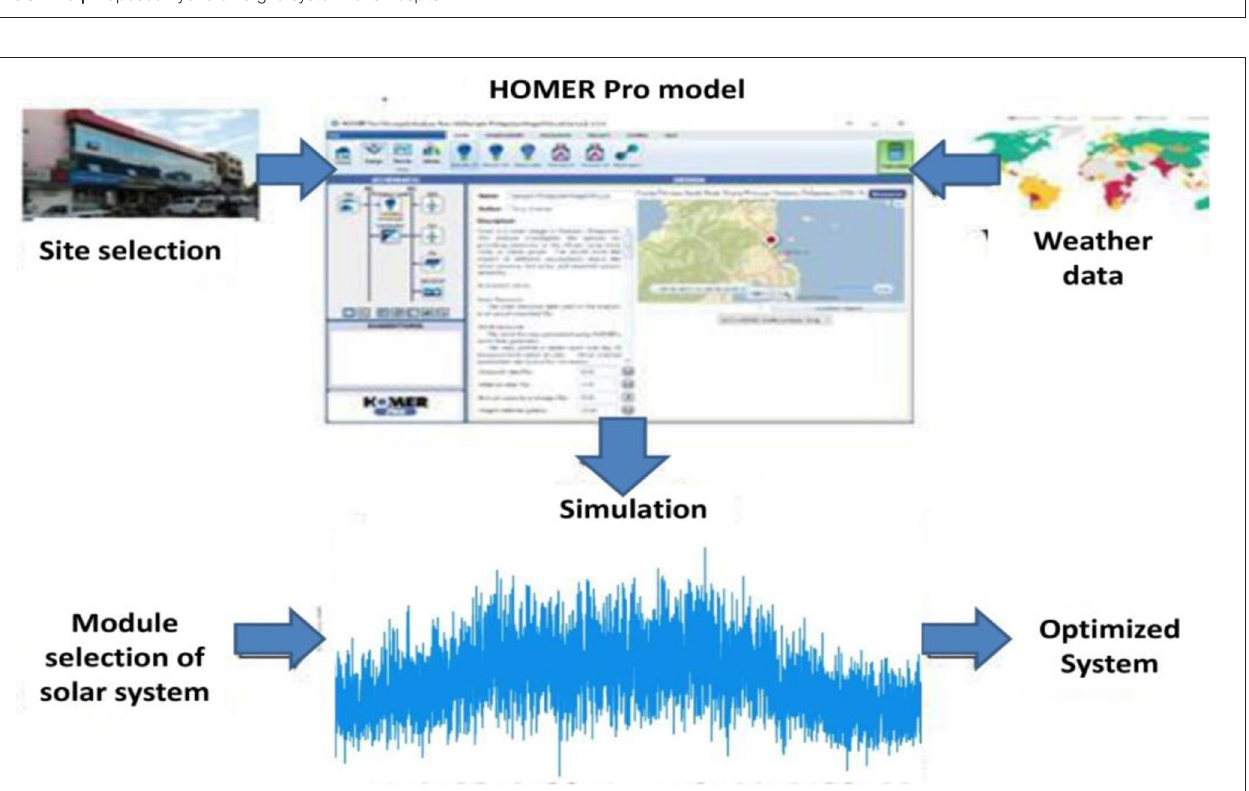
FIGURE 6 | Schematic of hybrid NZEB hospital building in HOMER Pro. month simulated in HOMER Pro. The total thermal load estimated for the hospital building in Taxila is 53 Ton. This is the required need of air-conditioning of the